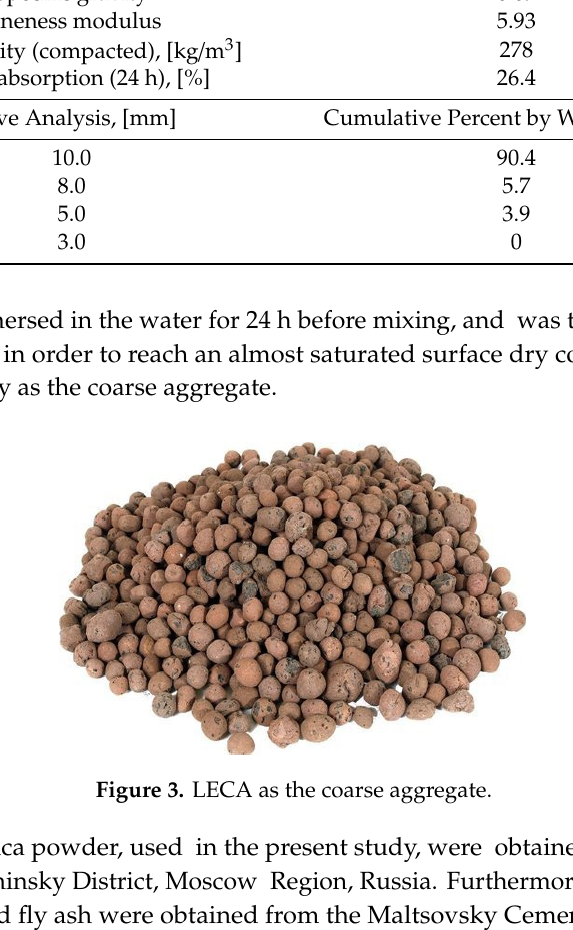
Table 2. Physical properties of silica sand.